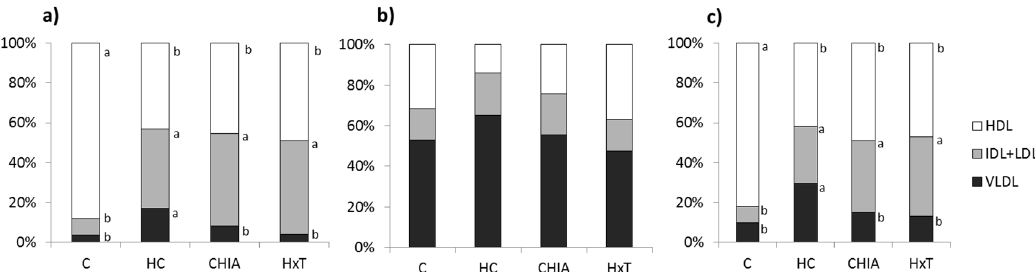
Figure 2. Lipid percentage transport in the different lipoproteins: VLDL, IDL + LDL, and HDL, in rats fed the experimental diets. ( a ) Cholesterol, ( b ) triglycerides, and ( c ) phospholipids. C, control-RP diet; HC, cholesterol-enriched, high-saturated/high-cholesterol, control-RP diet; HxT, hydroxytyrosol-RP, cholesterol-enriched, high-saturated/high-cholesterol diet; CHIA, Chia oil-RP, cholesterol-enriched, high-saturated/high-cholesterol diet. VLDL, very low-density lipoproteins; IDL, intermediate-density lipoproteins; LDL, low-density lipoproteins; HDL, high-density lipoproteins. Mean values within the same lipoprotein for C, HC, CHIA, or HxT with unlike letters were significantly different ( p < 0.05, T2 Tamhane test), represented by vertical areas (a > b > c).